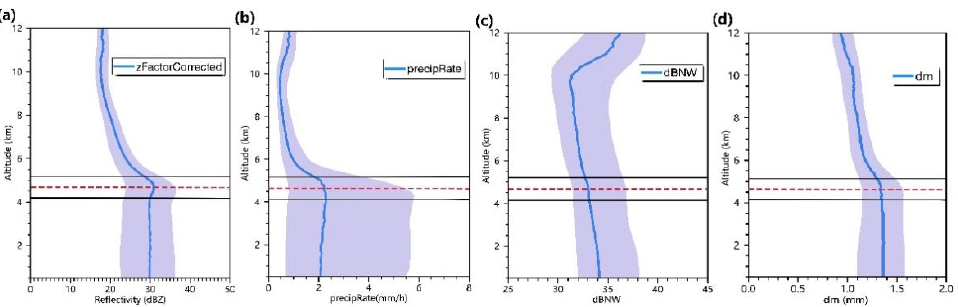
Figure 7. Vertical profiles of the ( a ) radar reflectivity, ( b ) precipitation intensity, ( c ) particle number concentrations and ( d ) particle diameters from the GPM satellite data. The dashed red line represents the 0 ◦ C layer, and the black lines denote the range of 1 km above and below the 0 ◦ C layer (17:00 on 6